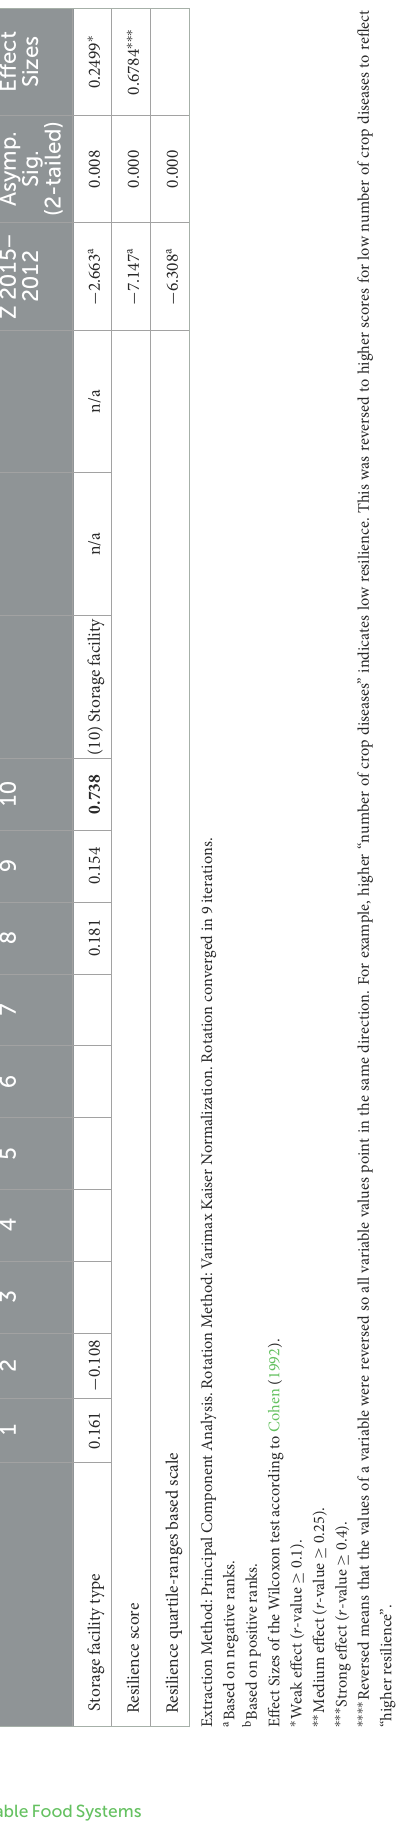
from 8.19 to 7.63 in 2012, and from 4.33 to 14.47 in 2015 − − (Table 4). The mean resilience score of 1.275 in 2012 increased − to 1.275 in 2015 (Figure 5). While the resilience scores for 2012 did not significantly deviate from normality according to the Kolmogorov-Smirnov test at p < 0.01 (D (111) 0.053, p 0.200), = = the scores for 2015 differed significantly from normality (D (111) 0.111, p 0.002). In 2012, one respondent and in 2015, four = = respondents at the high end of the scale were considered outliers (Table 4). In 2012 as well as in 2015, the majority of respondents were